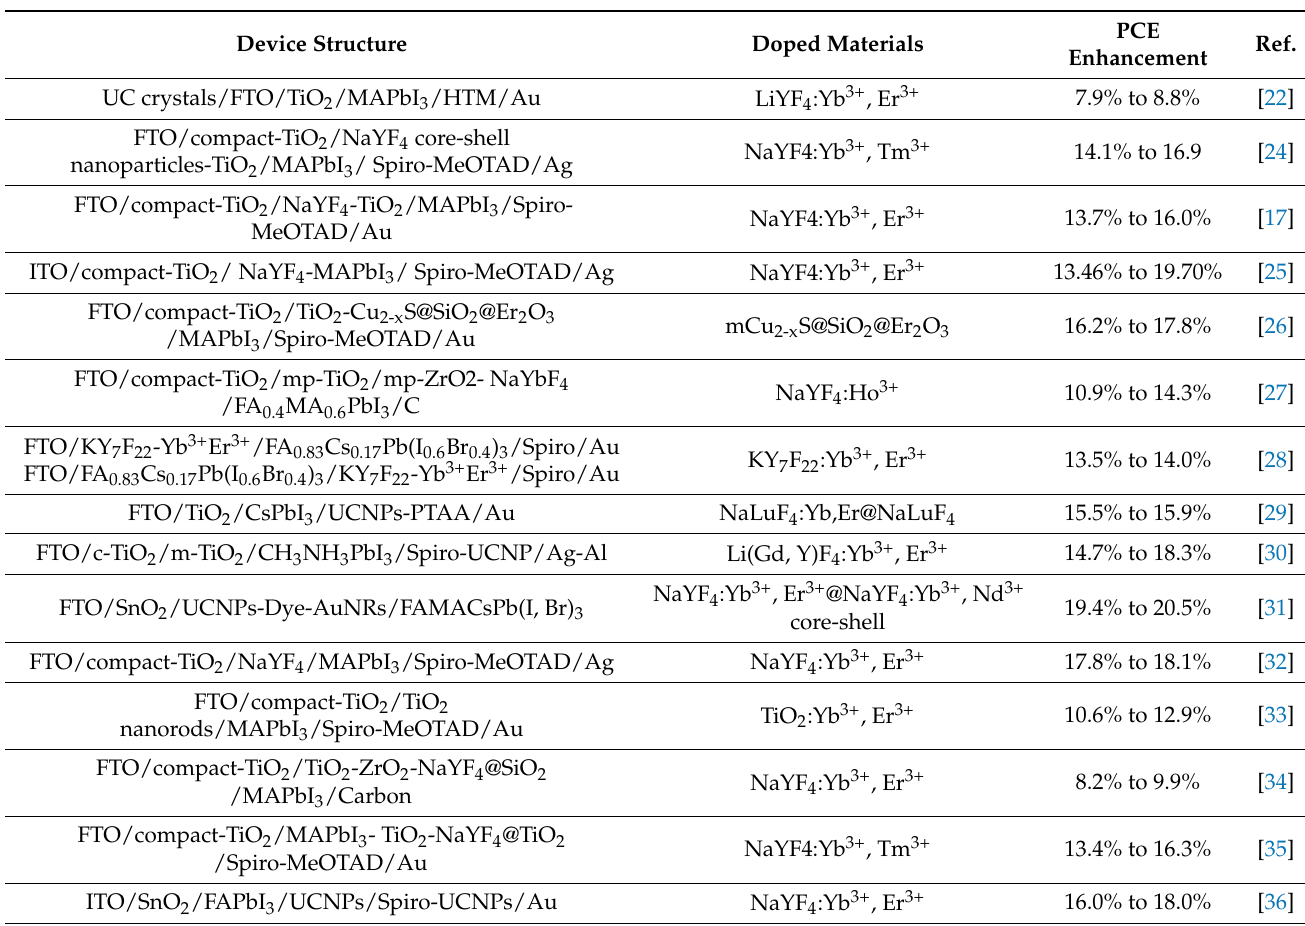
Table 1. The PCE enhancement of up-conversion Ln 3+ -doping solar cell device. Device Structure Doped Materials